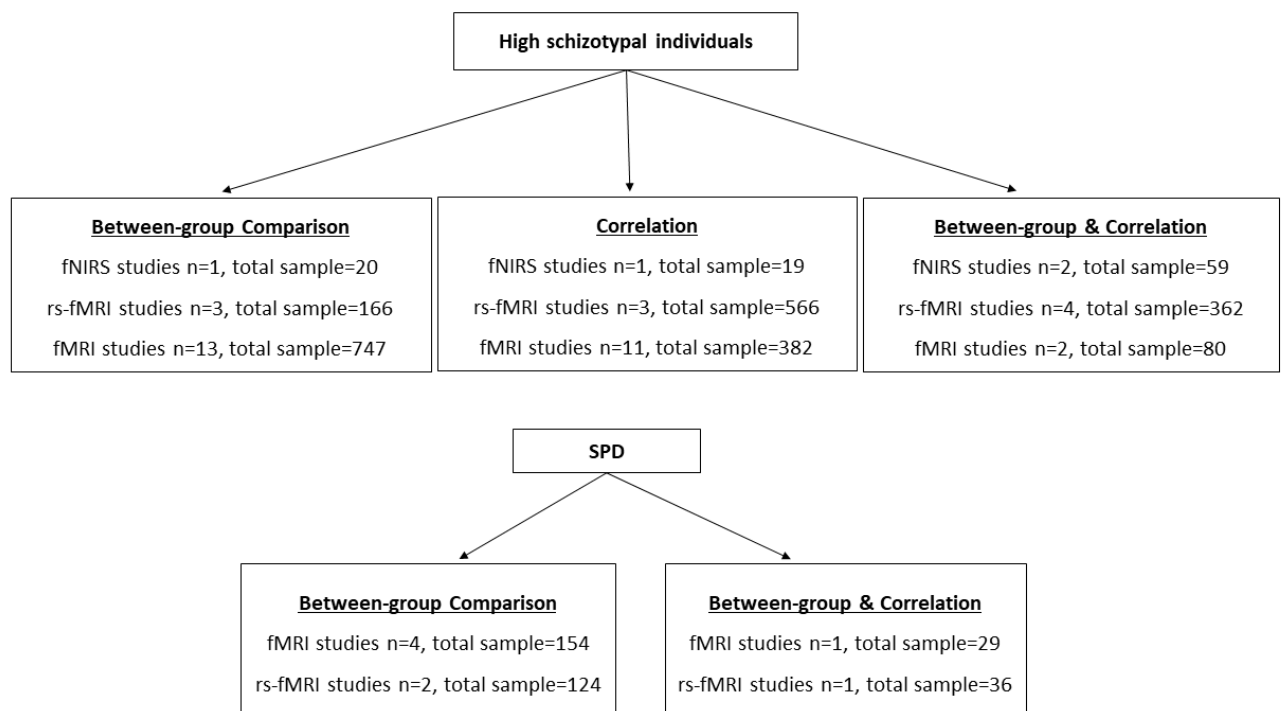
Figure 2. Total sample and number of between-group comparison and correlation studies included in the systematic review.